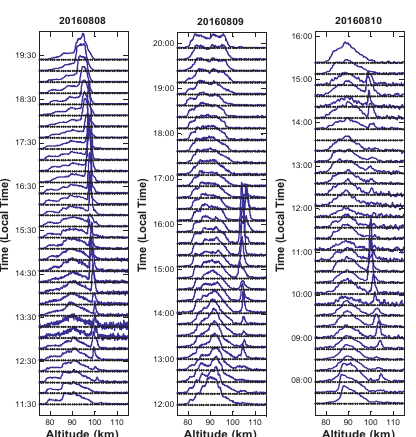
Fig. 2 Nas observed in the daytime for three consecutive days (each profile was integrated with 15 min, and the spatial resolution is 96 m)